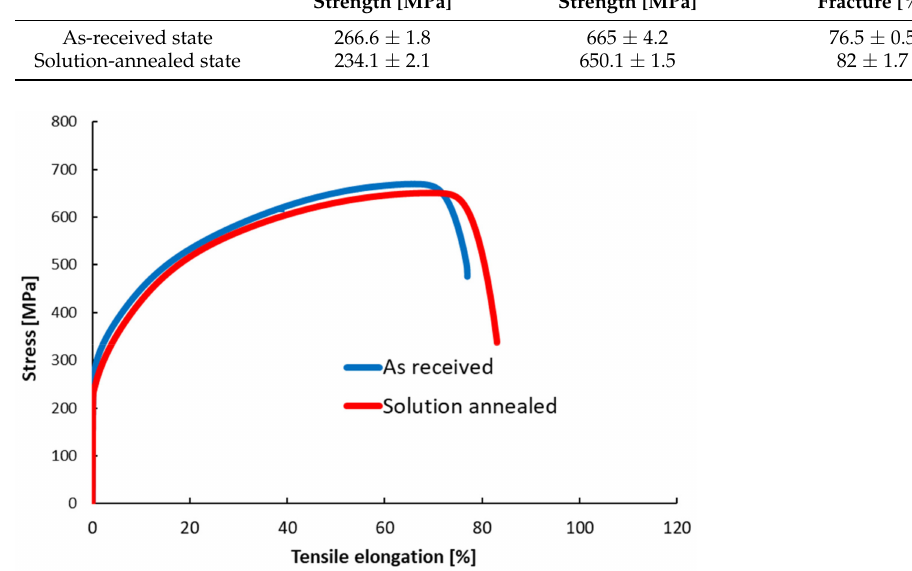
Figure 3. Stress-tensile elongation curves of experimental material AISI